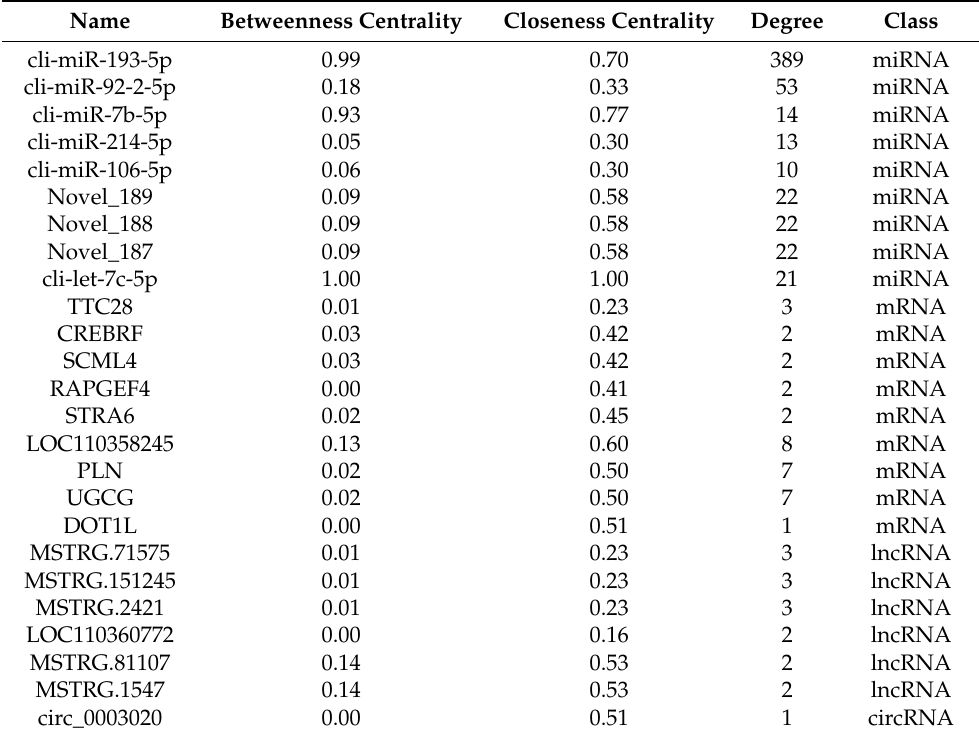
Table 3. Hub RNAs of ceRNA